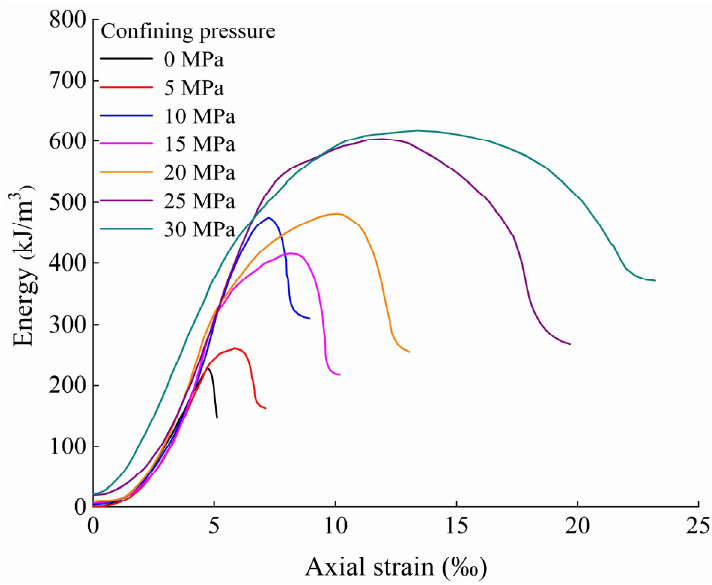
Figure 16. Variation in the elastic strain energy of marble with axial strain under different confining pressures at 0 thermal cycles.